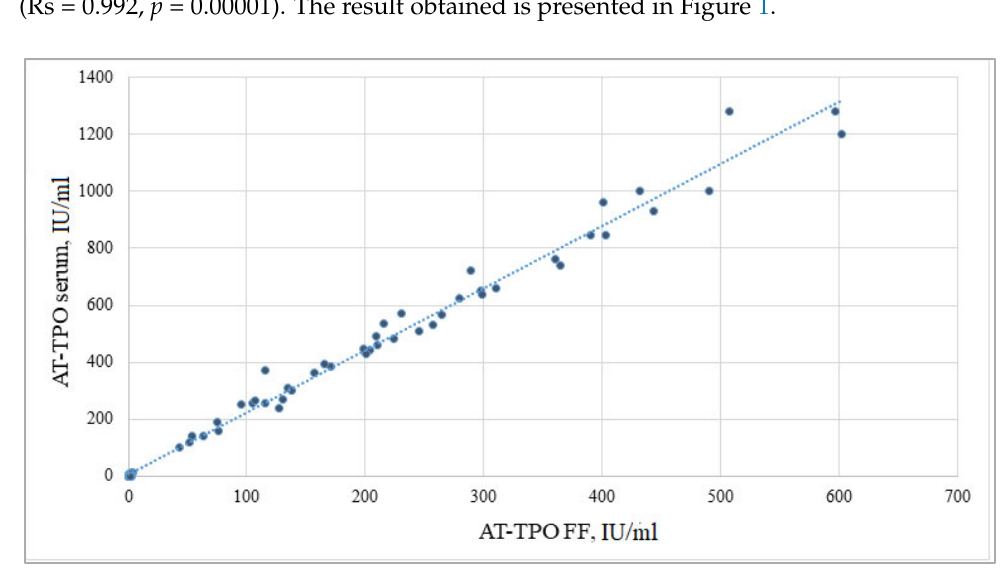
Figure 1. Correlation between serum and follicular fluid anti ‐ thyroid peroxidase antibody levels. AT ‐ TPO—anti ‐ thyroid peroxidase antibody; FF—follicular fluid .